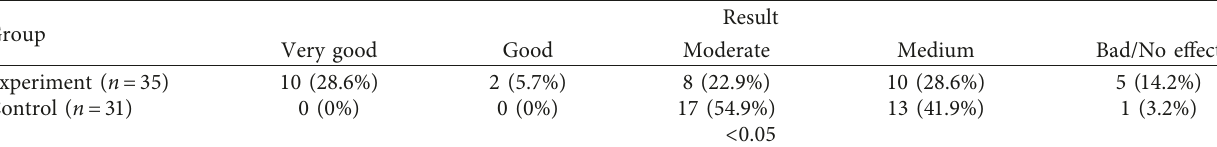
Table 5: Results of treatment in two groups according to the rate of PASI reduction after 3 months ( n � 66).